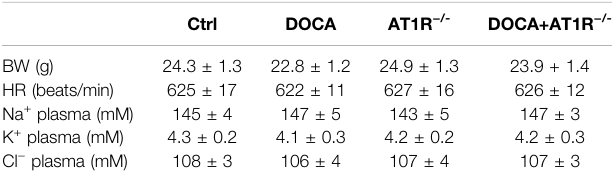
TABLE 2 | Effects of AT1R − /- on BW, HR, and plasma electrolyte in DOCA- salt mice. Ctrl DOCA AT1R − /- DOCA+AT1R −